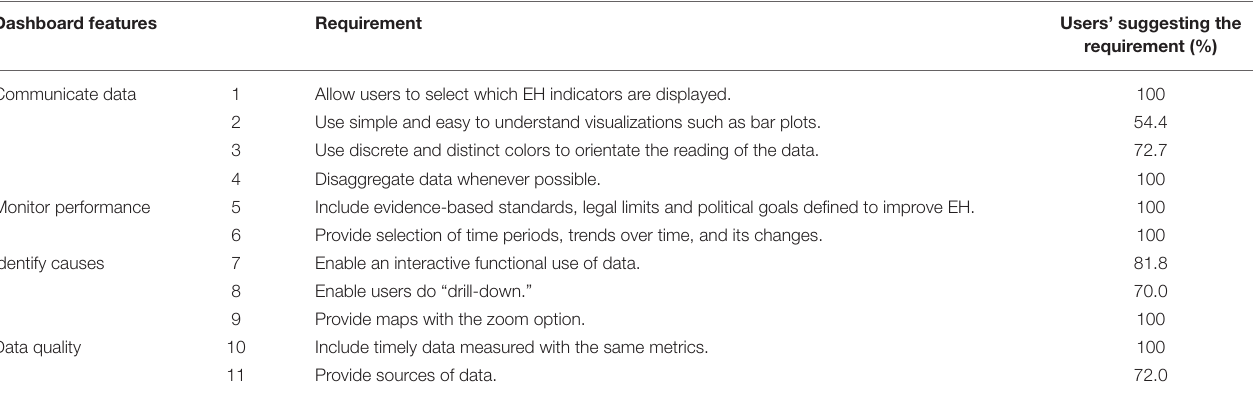
TABLE 2 | Requirements for a dashboard to monitor EH in the Lisbon city. Dashboard